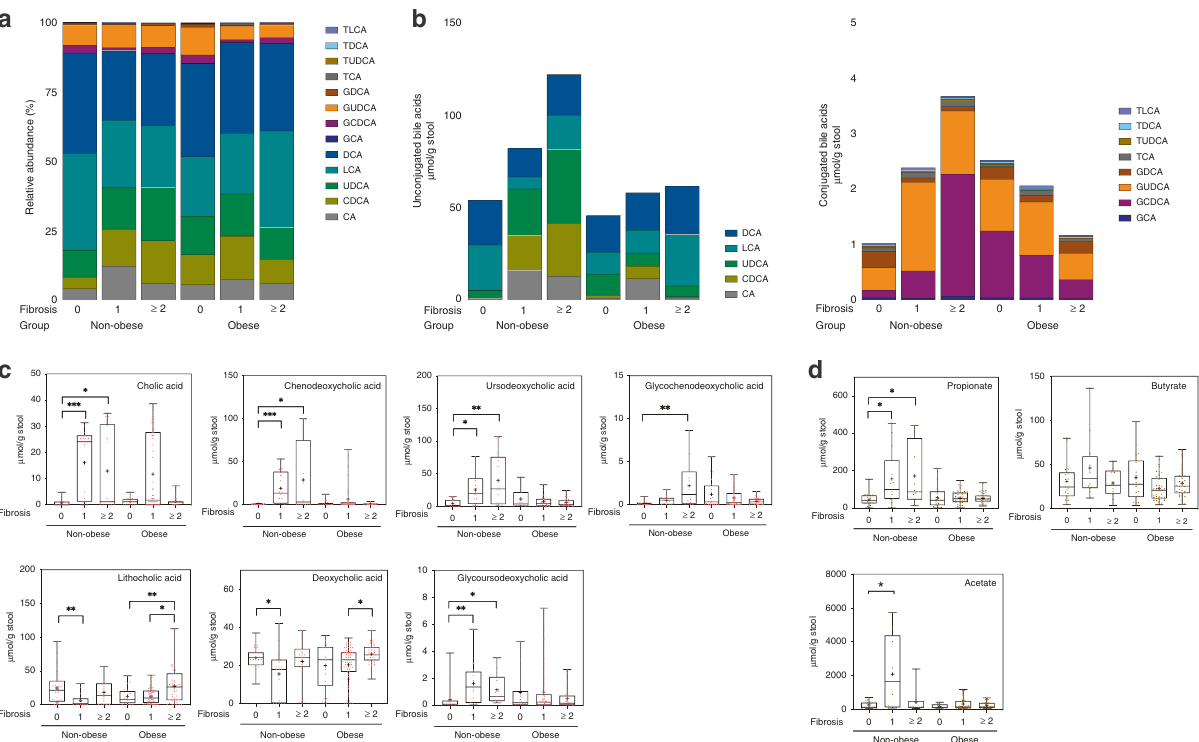
Fig. 3 Comparison of stool metabolites levels strati fi ed by fi brosis severity and obesity status. a Composition of bile acid pro fi les in different clinical settings. Stacked plots are generated using the average abundances of the 13 bile acids. b The stacked bars represent (left) unconjugated bile acids levels and (right) conjugated bile acids levels, which are strati fi ed by fi brosis severity and obesity status. c Box plots represent the concentrations of the stool bile acids, which are strati fi ed by fi brosis severity and obesity status; cholic acid (CA), *** P = 0.0007, * P = 0.0260, n = 57 for non-obese, and n = 111 for obese; chenodeoxycholic acid (CDCA), *** P < 0.0001, * P = 0.0164, n = 54 for non-obese, and n = 96 for obese; ursodeoxycholic acid (UDCA), * P = 0.0107, ** P = 0.0012, n = 56 for non-obese, and n = 95 for obese; glycochenodeoxycholic acid (GCDCA), ** P = 0.0023, n = 52 for non-obese, and n = 110 for obese; lithocholic acid (LCA), ** P = 0.0075, * P = 0.0265, ** P = 0.0045, n = 59 for non-obese, and n = 122; deoxycholic acid (DCA), * P = 0.0119, * P = 0.0128, n = 60 for non-obese, and n = 122 for obese; glycoursodeoxycholic acid (GUDCA), ** P = 0.0064, * P = 0.0115, n = 47 for non-obese, and n = 99 for obese. d Box plots represent the most abundant fecal short-chain fatty acids (SCFAs) levels (acetate, propionate, and butyrate), which are strati fi ed by fi brosis severity and obesity status; propionate, * P = 0.0114, * P = 0.0182, n = 51 for non-obese, and n = 100 for obese; butyrate, n = 43 for non-obese, and n = 98 for obese; acetate, * P = 0.0440, n = 42 for non-obese, and n = 89 for obese. The box plots indicate the median, 25th to 75th percentiles (boxes), and minimum to maximum values (whiskers). Outliers were removed by the ROUT method ( Q = 1%) and data were analyzed using a nonparametric Kruskal – Wallis test with Dunn ’ s multiple comparison test. * P < 0.05, ** P < 0.01, *** P < 0.001. Taurolithocholic acid (TLCA), taurodeoxycholic acid